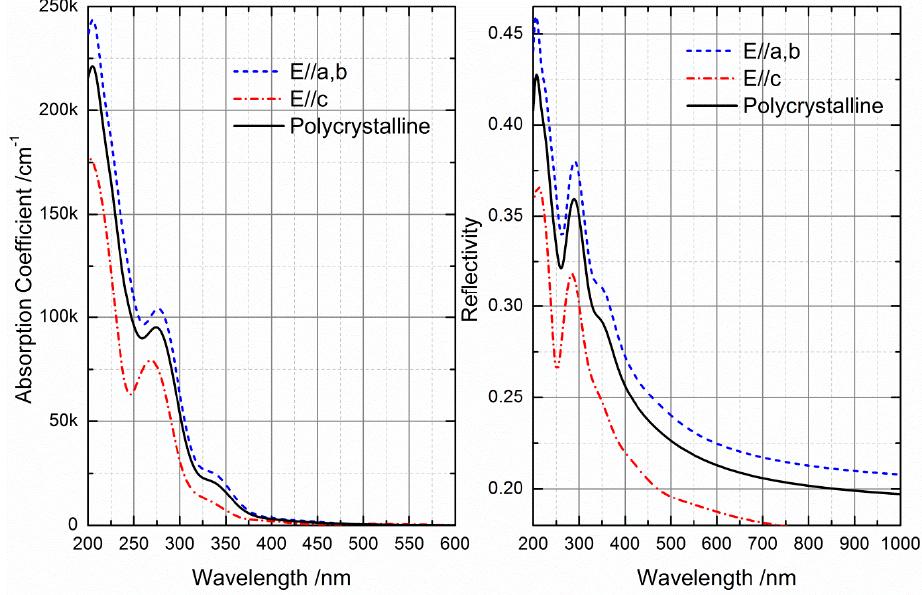
Figure 9. Absorption coefficient and reflectivity of BiOI along two polarization directions and for the polycrystalline model obtained by the HSE06 method.